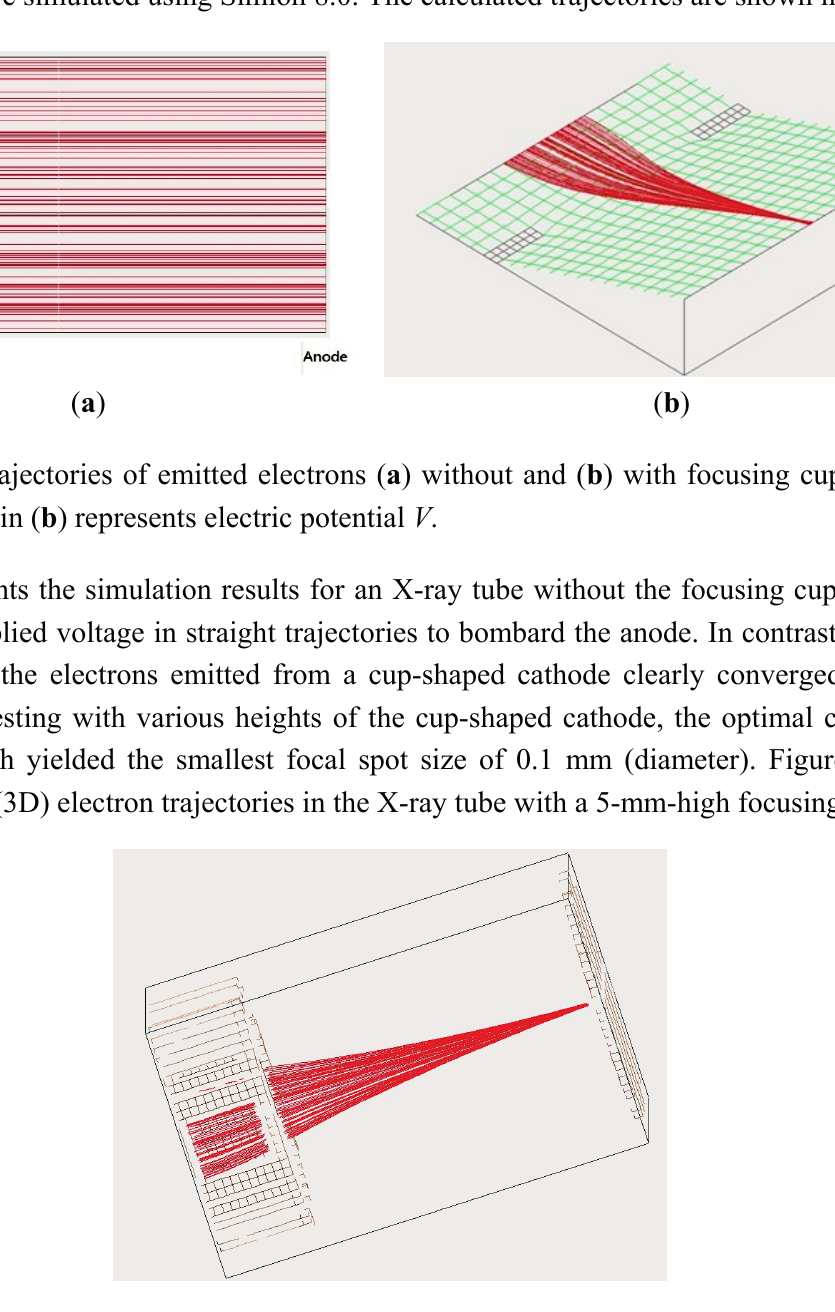
Figure 4. Three-dimensional (3D) diagram of electron trajectories in the X-ray tube with a 5-mm-high focusing